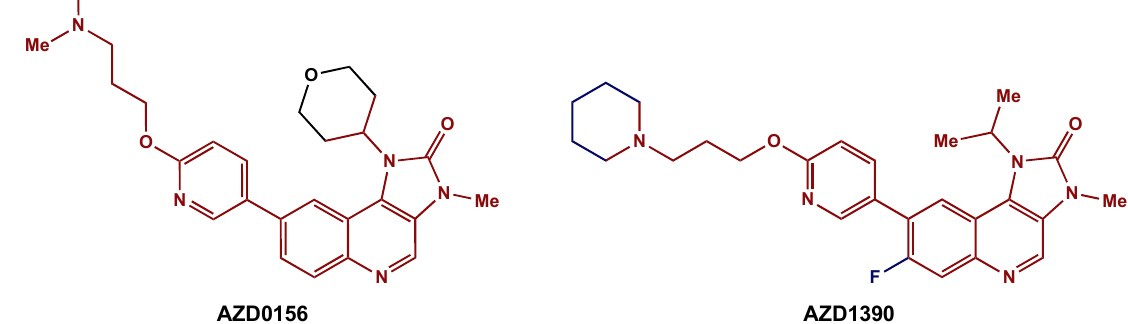
Figure 6. ATM inhibitors: AZD0156 was modified to AZD1390, an orally available compound with greater blood–brain barrier penetrance. The preserved core is highlighted in